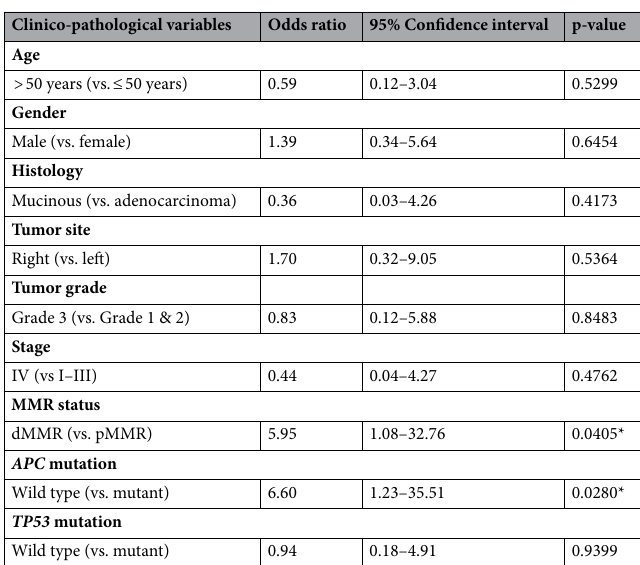
Table 4. Multivariate logistic regression analysis to assess relationship between RNF43 mutation and clinico- pathological characteristics. *Significant p value.